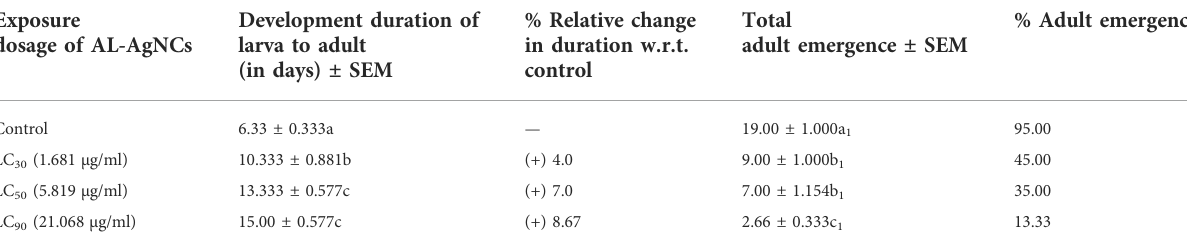
TABLE 1 Development duration and the adults emerged from the early fourth instar larvae of Aedes aegypti exposed to the silver nanocomposites synthesized from the leaf extracts of Achyranthes aspera (AL-AgNCs) for 24 h. Exposure dosage of